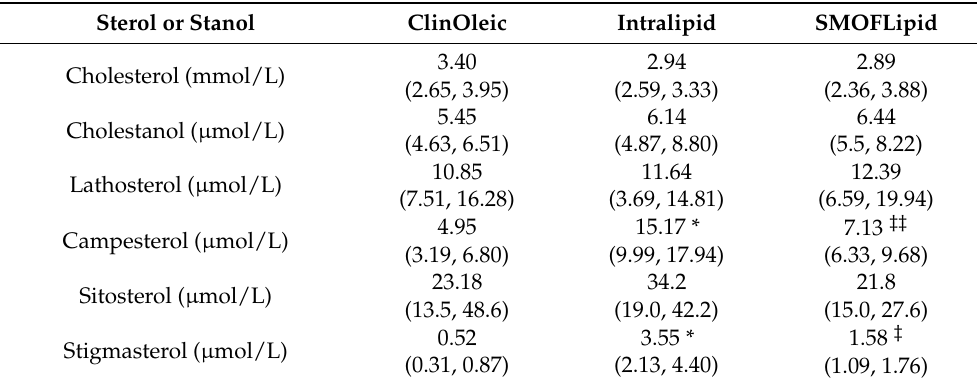
Table 3. Plasma sterol concentrations in patients according to the lipid emulsion being received. Data are median (interquartile